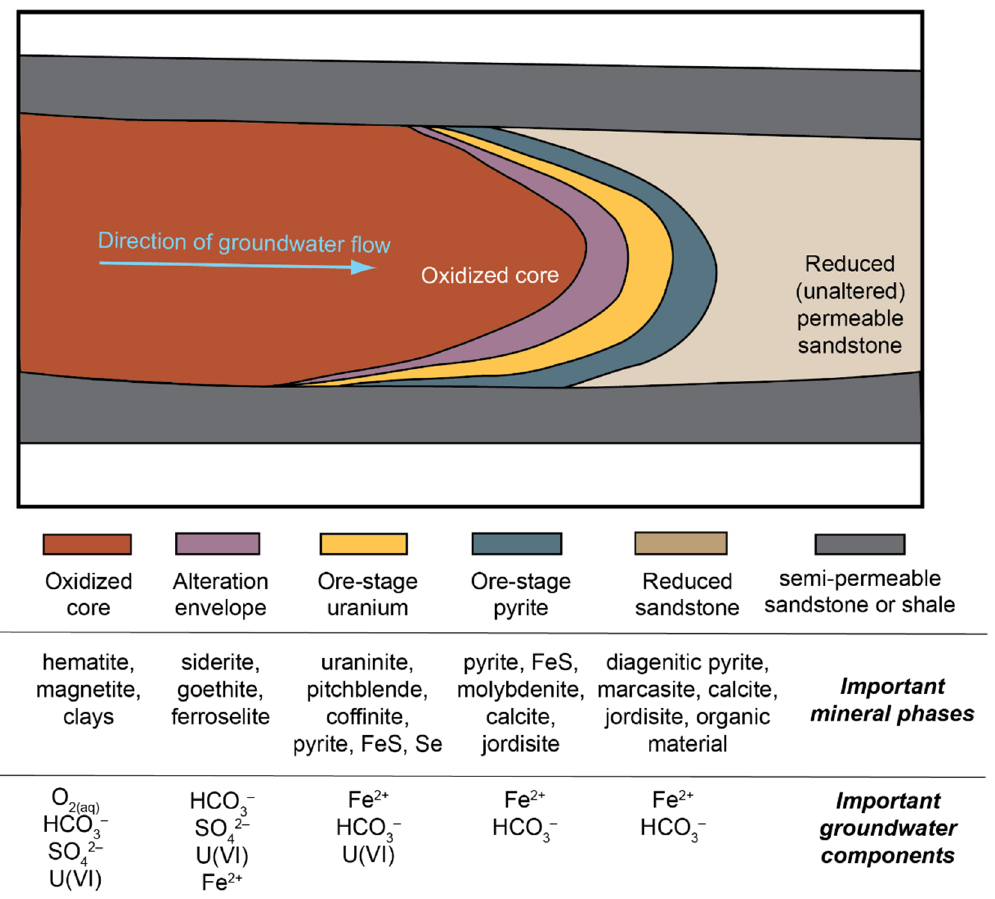
Figure 2. Cross section of generic roll front-type uranium deposit showing redox zoning, and changes in mineralogy and ground-water components along groundwater flow path direction, modified from [22].